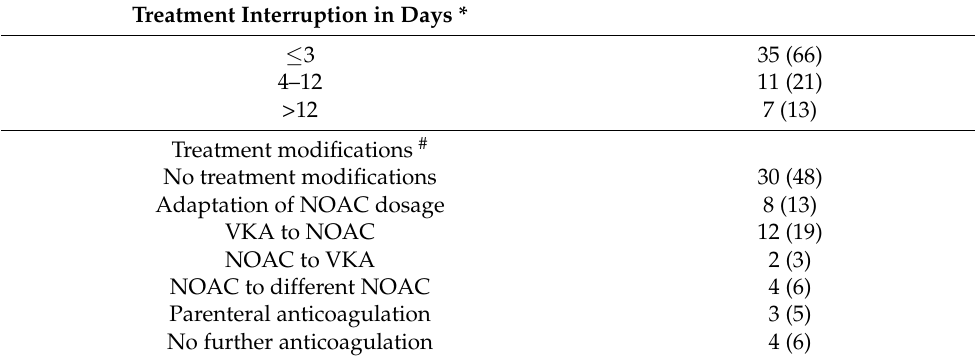
Table 3. Anticoagulation after